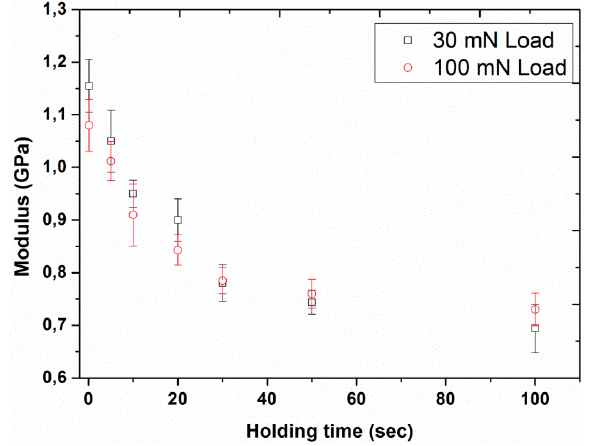
Figure 17. Modulus as a function of holding time for the two different peak loads, 30 and 100 mN with loading time of 10 s. Bars represent standard deviations.